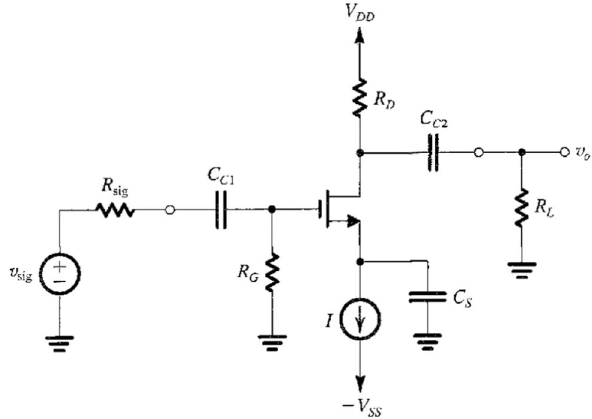
Fig. 3 The basic layout of the common-source amplifier using the SG MOSFET [3]